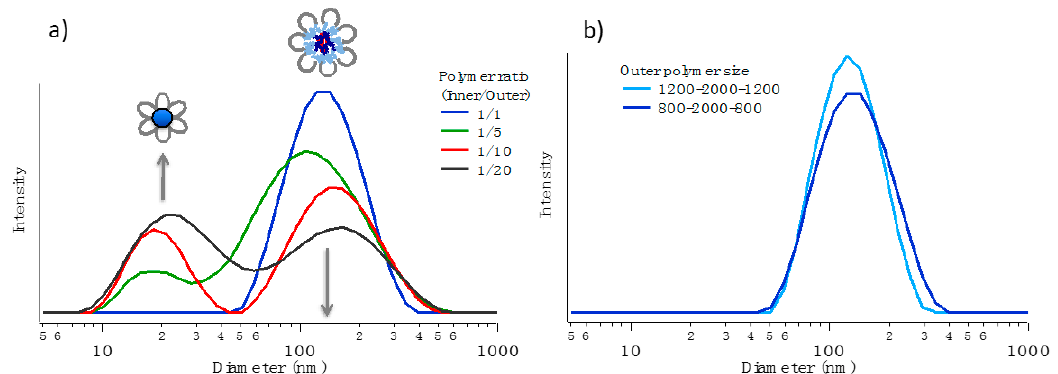
Figure 2. DLS intensity analysis of: ( a ) 3LM compositions prepared by di ff erent weight ratios of PLLA-PEI-PLLA (inner layer) and PLLA-PEG-PLLA (outer layer); ( b ) 3LM sizes at inner;outer ratio 1:1, but di ff erent PLLA block length of outer block